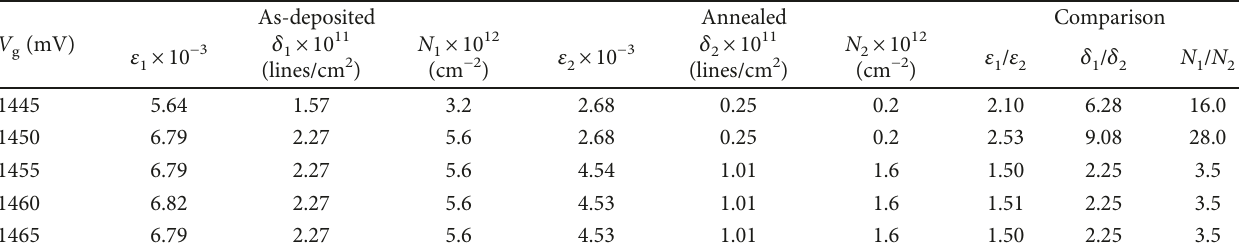
Table 3: Evaluation of strain and dislocation density of the CdS fi lms deposited at di ff erent cathodic voltages. As-deposited Annealed V (mV) g